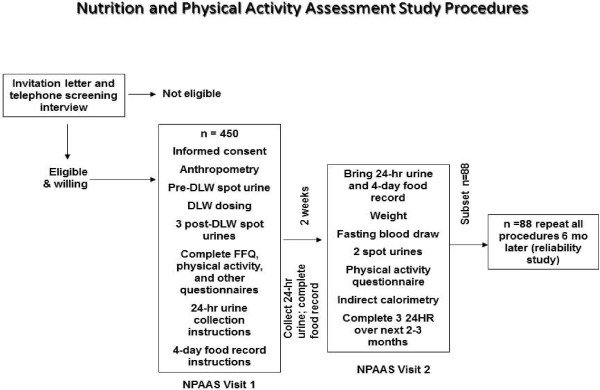
Ross L. Prentice, Mossavar-Rahmani et al. Evaluation and comparison of food records, recalls, and frequencies for energy and protein assessment by using recovery biomarkers Am. J. Epidemiol. (2011) 174(5): 591-603, Fig. 1.